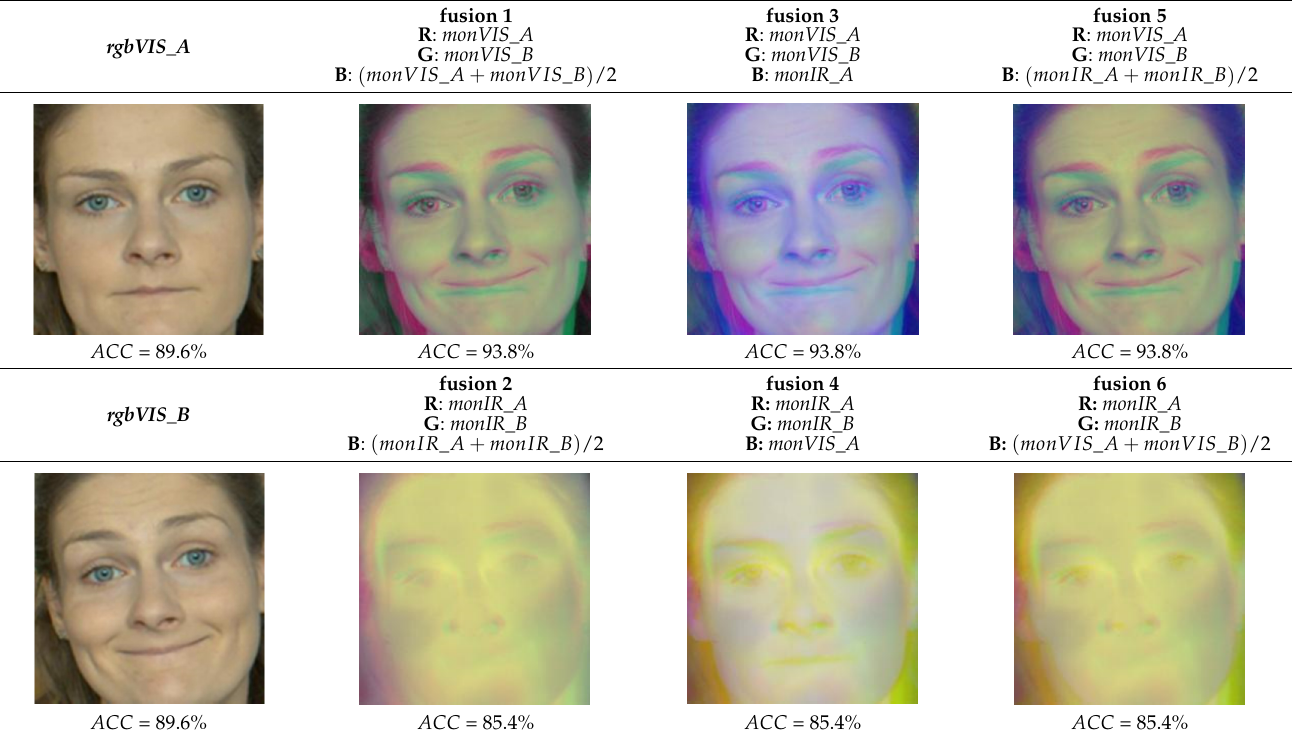
Table 3. Examples of RGB class images used as AlexNet input.